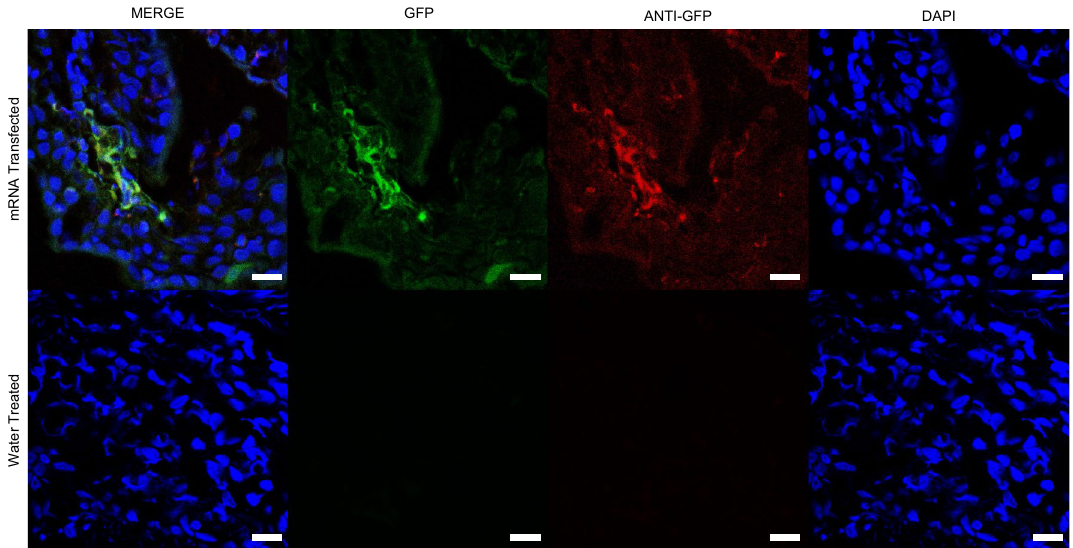
Figure 5. Immunohistochemical demonstration of green fluorescence in bronchial epithelium transfected with eGFP naked mRNA. Bronchial mucosal biopsies obtained 24 h after aerosolized transfection with 250 µg eGFP naked mRNA were fixed, cryosectioned, and mounted for fluorescent imaging. Immunohistochemistry staining of fixed samples stained with a polyclonal anti-GFP antibody labeled with Alexa Fluor 647, confirmed eGFP expression (green) in bronchial epithelium, co-localized with the anti-GFP (red) and nuclear staining (DAPI, blue). The merged image demonstrates that GFP was detected in the mucosal biopsy from the mRNA- transfected bronchus but not the water-treated bronchus, confirming the green fluorescence detected using FCFM. Note that the red anti-GFP does not always appear to co-localize with the eGFP because the latter was greatly diminished by tissue fixation, and because fixed tissues can produce green autofluorescence indistinguishable from GFP. The purpose of this figure is to demonstrate localization of GFP in respiratory epithelial cells, indicating successful transfection. White bars represent 10